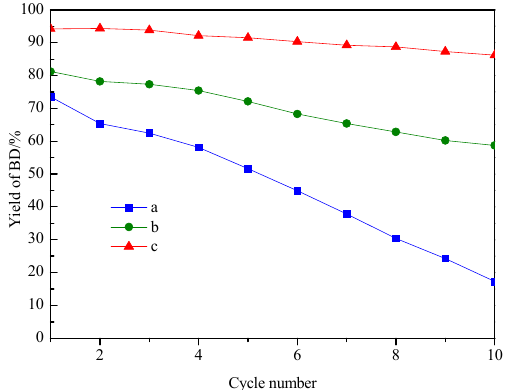
Figure 12. The yield of BD by Cu 2 O catalysts as a function of the cycle number. ( a ) Cu 2 O-NO 3 ; ( b ) Cu 2 O-Cl(1); ( c ) Cu 2 O-Cl(2). Reaction conditions: catalyst amount, 0.5 g, formaldehyde solution concentration, 39 vol.%, consumption of the formaldehyde solution, 50 mL, reaction temperature, 90 °C, reaction time, 24 h.